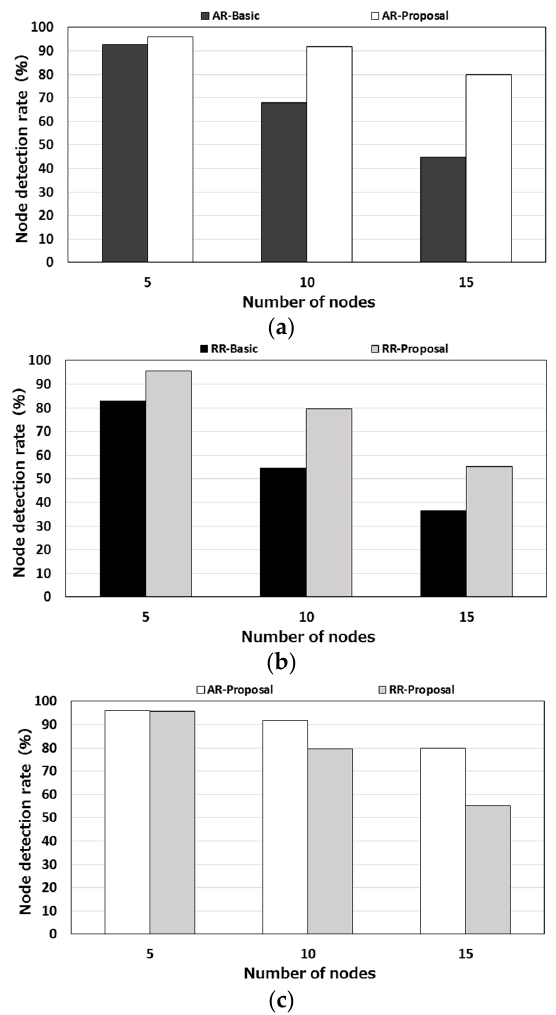
Figure 15. Stray node detection rate. ( a ) Node detection rates of the autonomous response-type stray node detection protocol; ( b ) node detection rates of the request-response-type stray node detection protocol; ( c ) node detection rates of the proposed protocols.